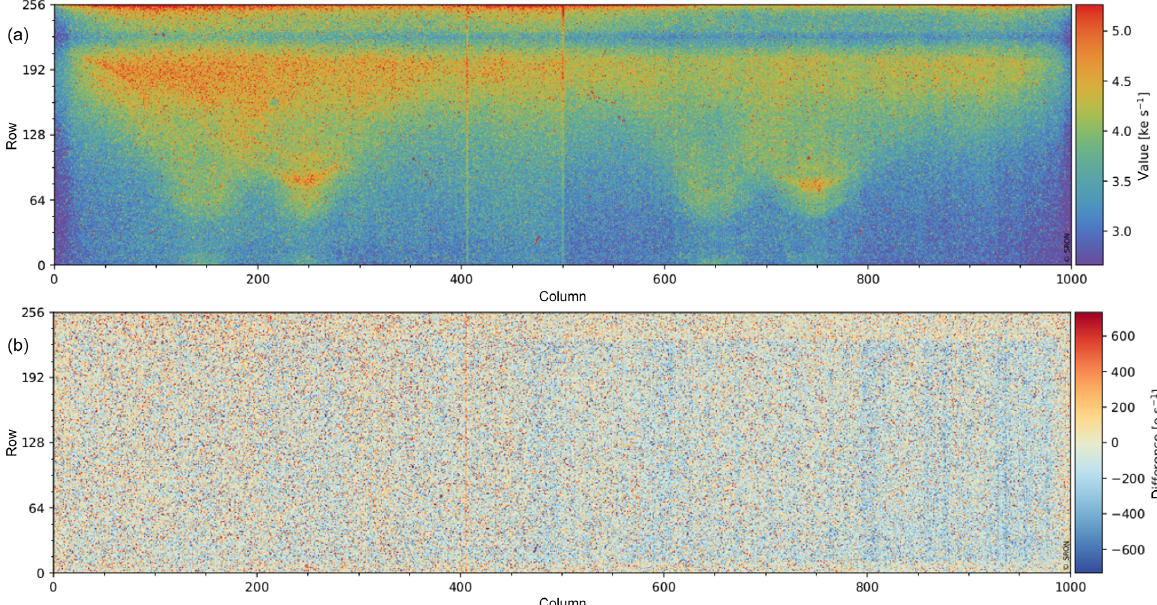
Figure 5. The typical dark current obtained with the FMM open during the commissioning phase using data from orbits 990 to 1004 can be seen in panel (a) . Data are plotted over the detector with the horizontal axis equivalent to the spectral direction and the vertical axis equivalent to the spatial swath. Panel (b) shows the result with the ground-based results